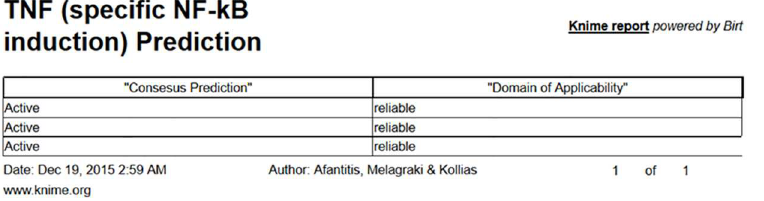
Fig 4. Prediction and reliability results regarding TNF inhibition upon structure submission of T23, T8 and SPD304 (see SMILES Fig 3) to the Enalos cloud